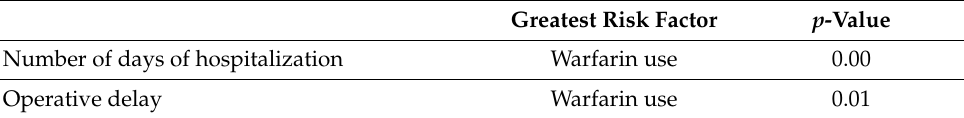
Table 5. Greatest predictor of postoperative